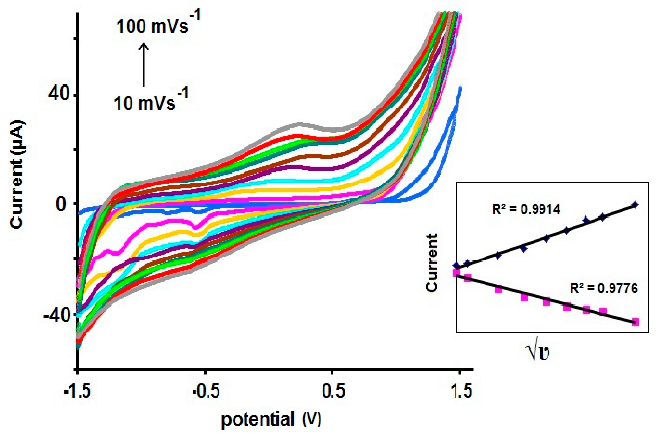
Figure 2. Cyclic voltammograms of PAni/MCC/CTAB-modified electrode with different scan rate. Inset: plot of oxidation and reduction peak current against square root of scan rate. All voltammograms were taken in 0.1 M PBS of pH 7.0 with a potential scan rate of 100 mV s − 1 at room